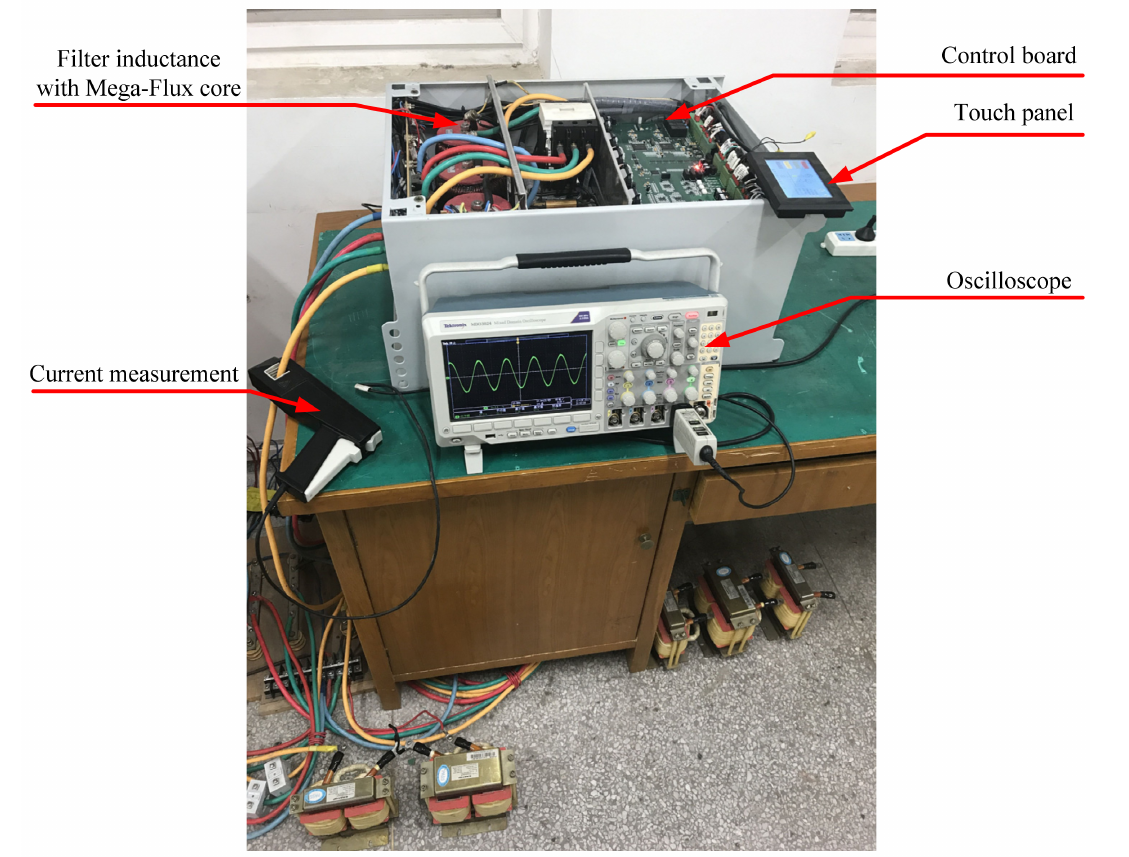
Figure 9. Experimental prototype of the